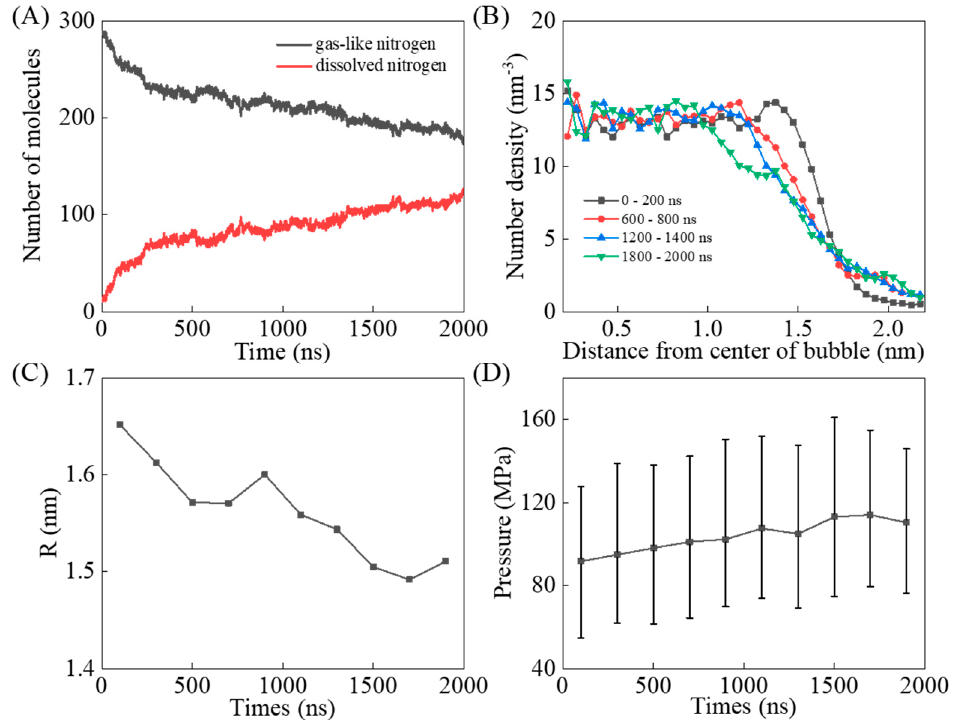
Figure 6. Time evolution of ( A ) nitrogen molecules in different states, ( B ) distribution of N 2 along the distance from center of bubble, ( C ) average radius of nitrogen bubble in each 200 ns, and ( D ) average inner pressure of the nitrogen bubble in each 200 ns.